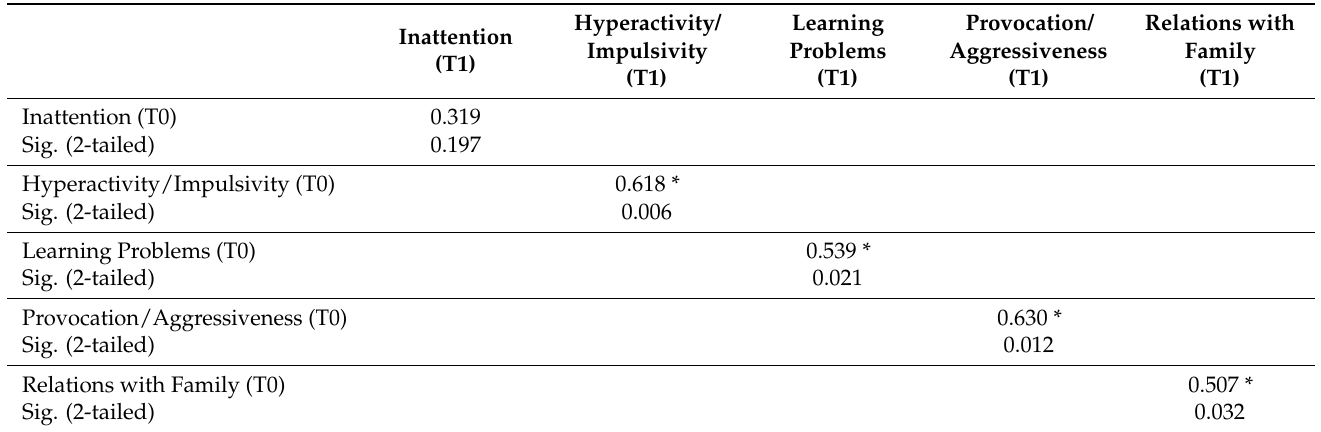
Table 2. Correlation study between the Conners-3 scale variables at T0 and